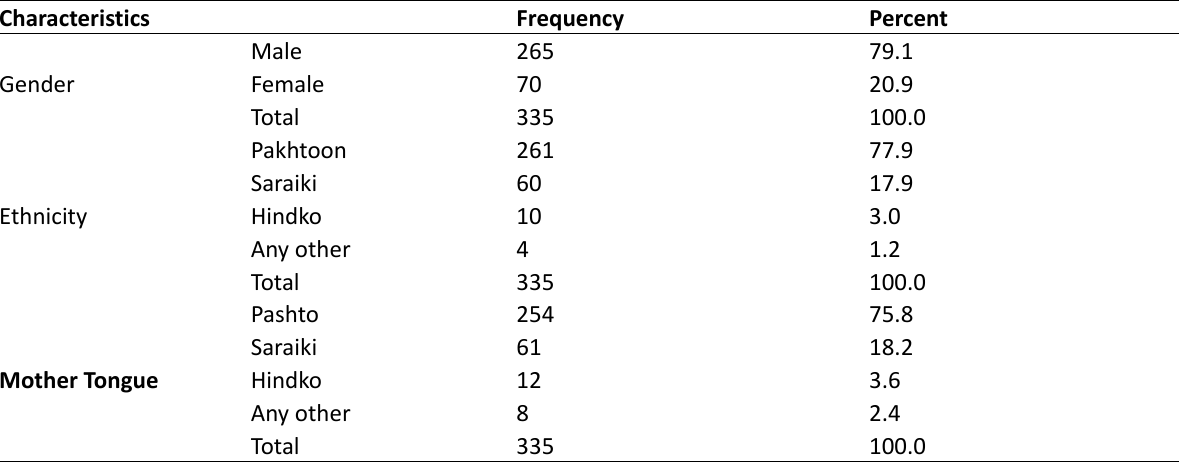
Table 1. Demographics characteristics of participants (n=335) Characteristics